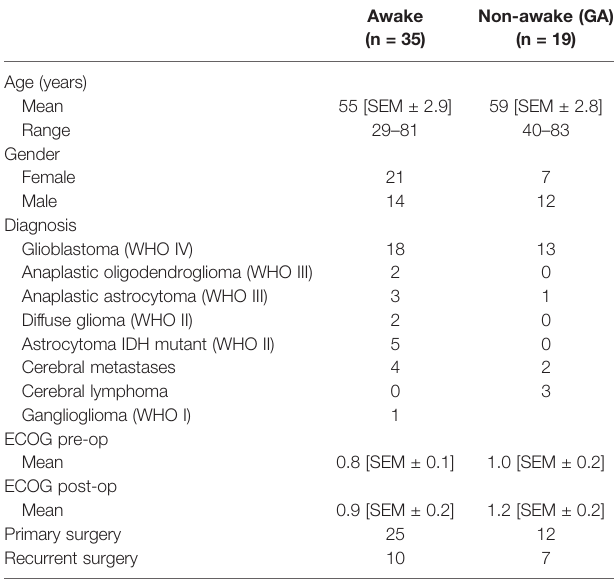
TABLE 1 | Descriptive epidemiologic data of patient